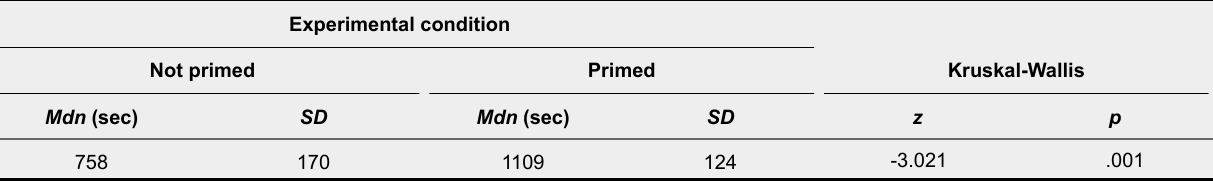
Results Experiment 1